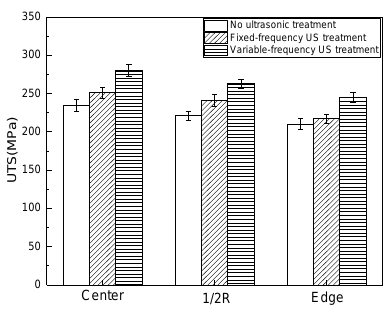
Figure 11. Ultimate tensile strength of ZK60 alloy with different ultrasonic treatments.